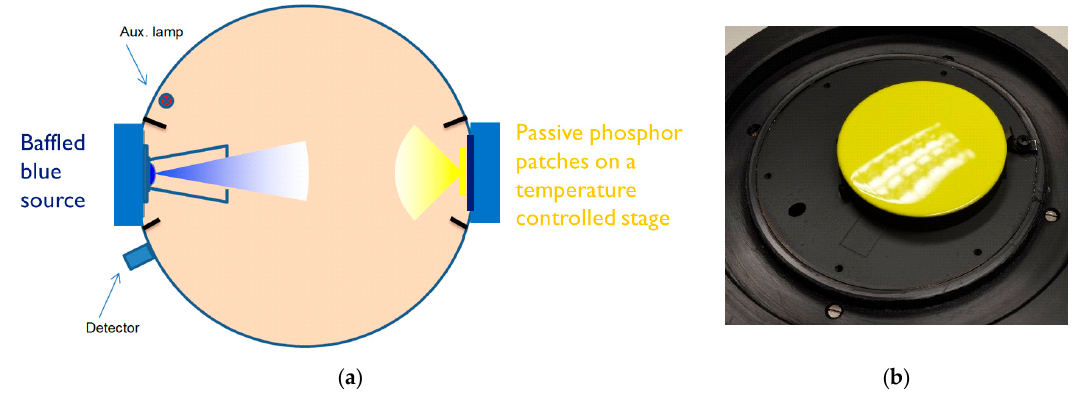
Figure 7. Test setup for phosphor sample measurements: ( a ) Schematic of the integrating sphere arrangement with excitation blue light source and passive phosphor layers attached to a temperature-controlled stage; ( b ) photograph of a custom-made phosphor sample attached to a temperature-controlled stage.